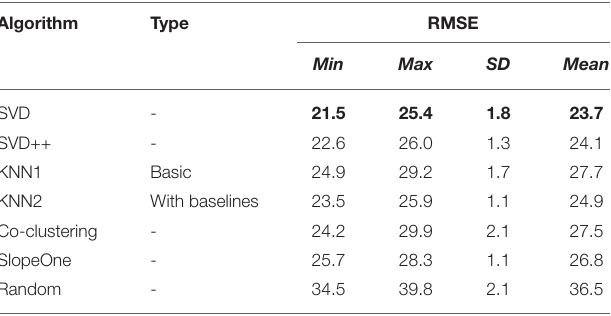
TABLE 1 | Results of the offline experiment, performed using five-fold cross-validation.